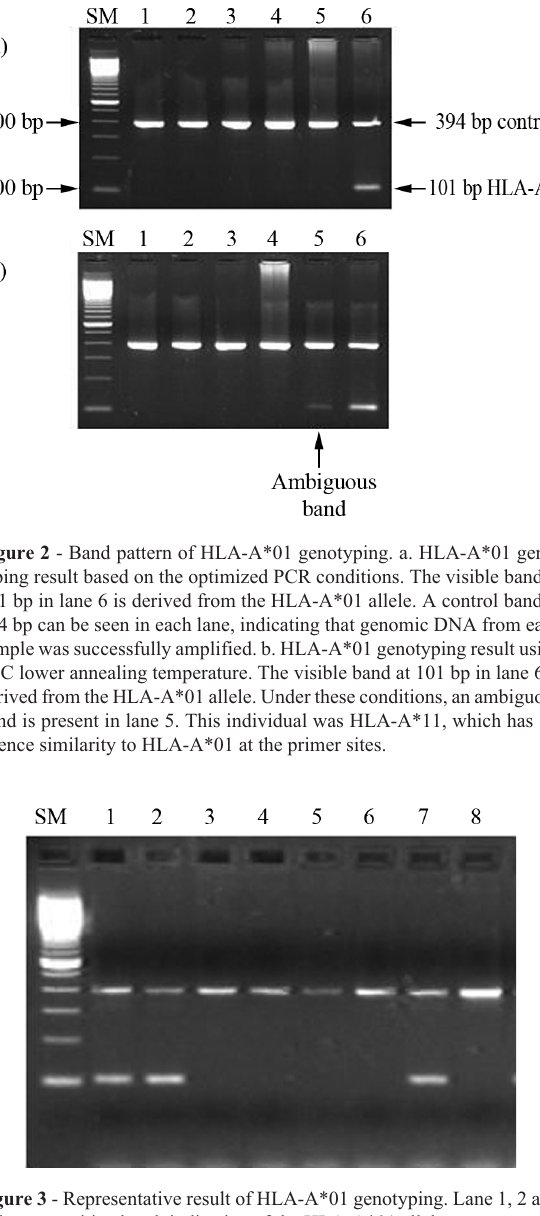
Figure 3 - Representative result of HLA-A*01 genotyping. Lane 1, 2 and 7 show a positive band, indicative of the HLA-A*01 allele.